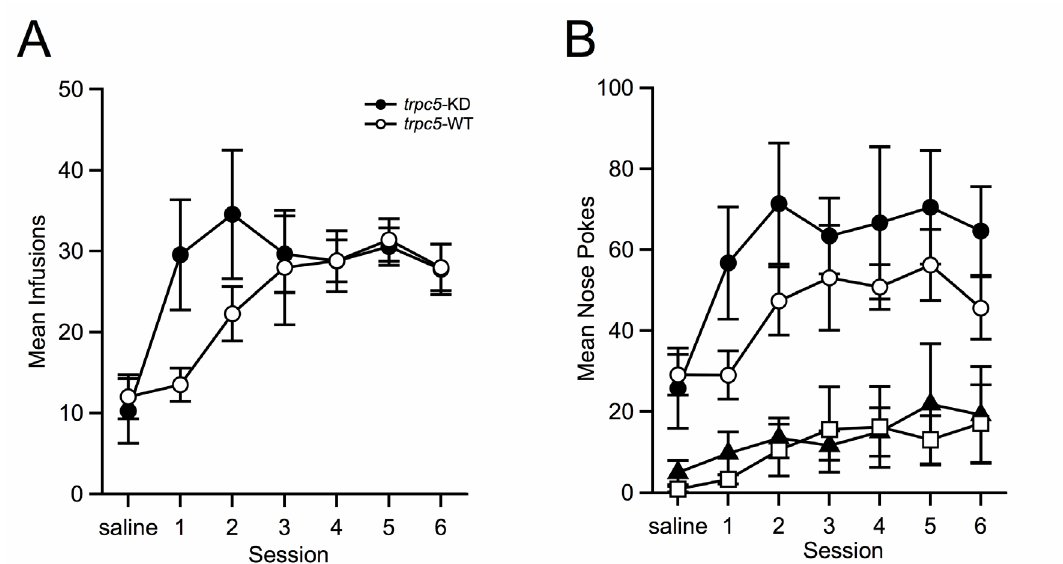
Figure 1. A. Mean (± SEM) number of saline (1 session) and cocaine (6 sessions) infusions. Saline responding is similar between genotypes, yet trpc5- KD mice exhibit an increased responding on day 1 for cocaine. Saline- trpc5- KD ( n = 8) versus Saline- trpc5- WT ( n = 8), Cocaine- trpc5- KD ( n = 9) versus Cocaine- trpc5- WT ( n = 10). B. Mean (± SEM) number of saline (1 session) and cocaine (6 sessions) nose-poking in active (rewarding) and inactive (non-reinforced) portals. Nose-poking for saline is similar between genotypes, yet trpc5- KD poking is significantly elevated on day 1 of responding for cocaine and continues throughout the sessions. Black circles represent trpc5- KD active poking, open circles represent trpc5 -WT active poking, triangles represent trpc5- KD inactive poking, squares represent trpc5- WT inactive poking.